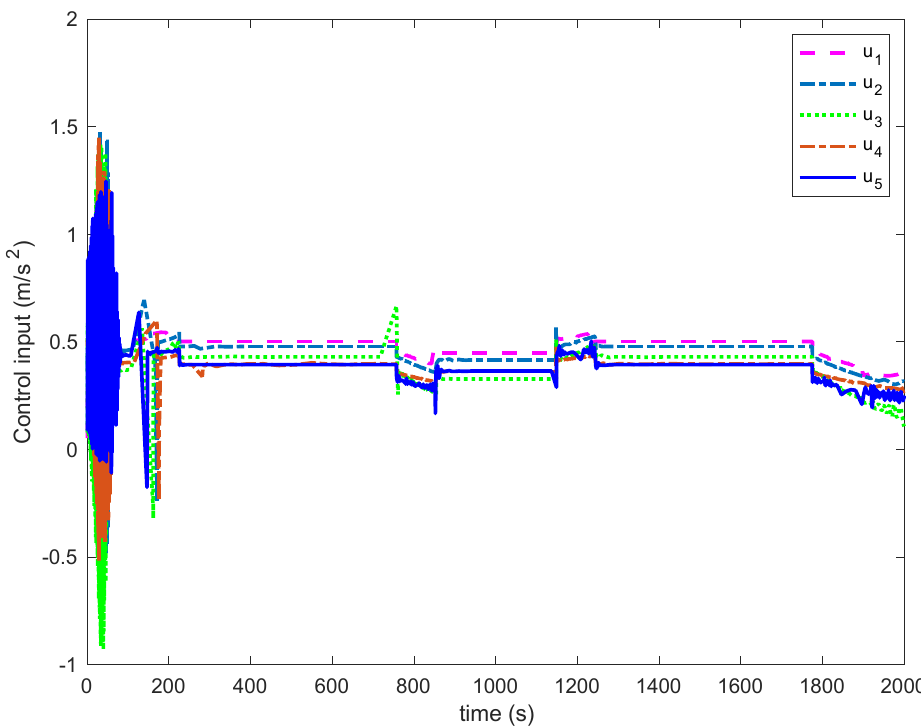
Figure 12. Control input curves for single-value learning.